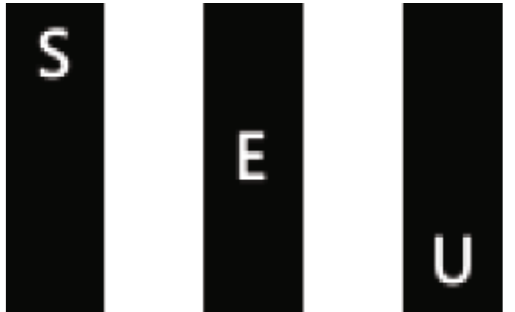
Figure 5: The refocus image sequences.